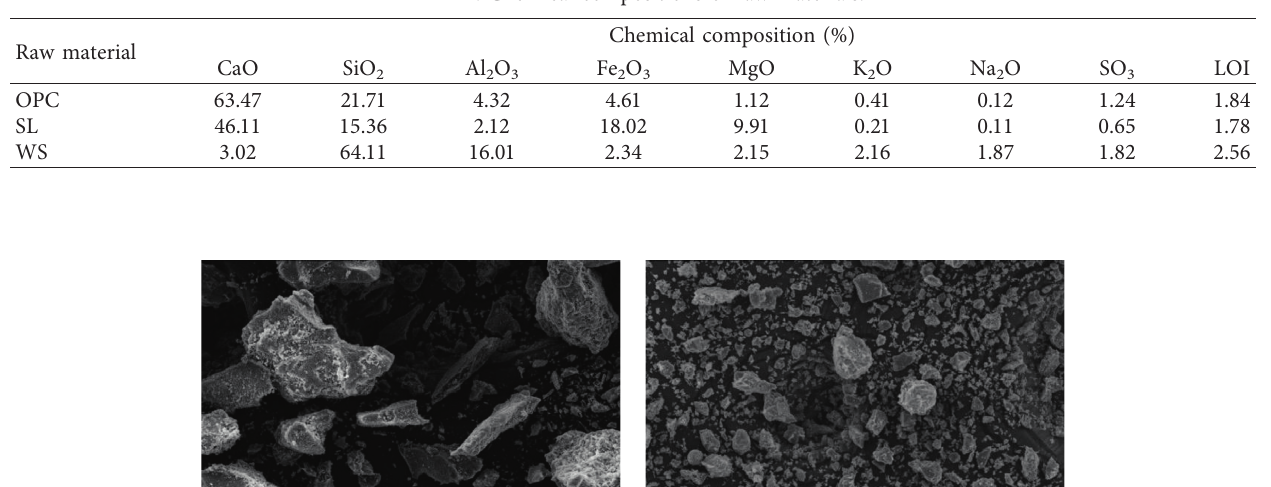
Table 1: Chemical compositions of raw materials.